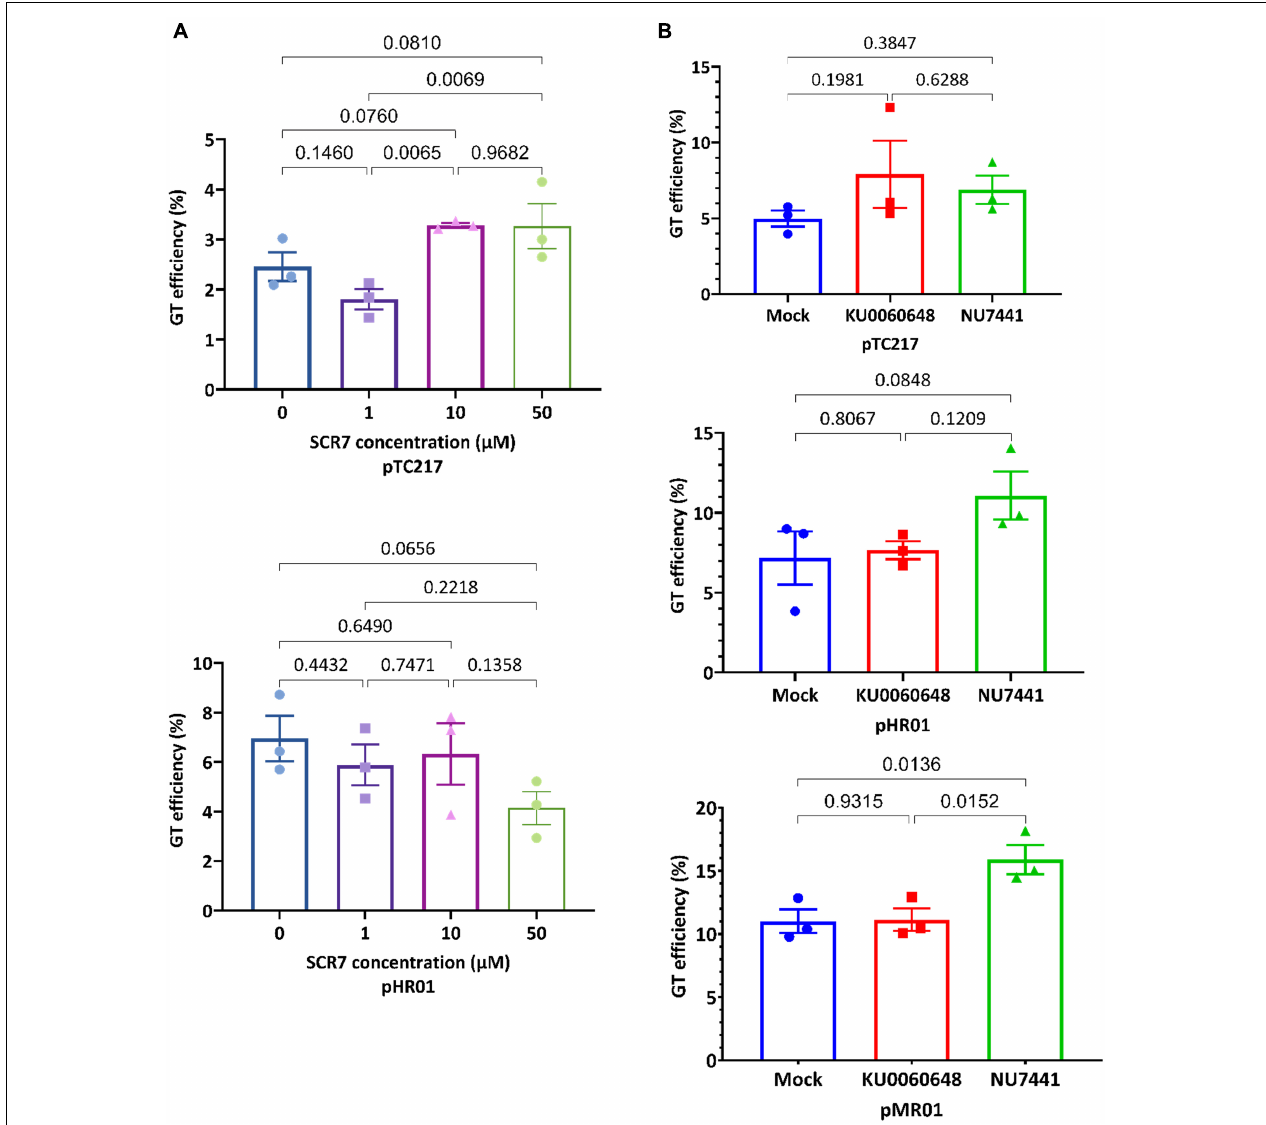
FIGURE 1 | Enhancement of GT efficiency by chemical treatments for blocking cNHEJ. (A) SpCas9 (pTC217, top panel) and LbCas12a (pHR01, bottom panel)-based GT efficiency obtained from the treatment of different SCR7 concentrations. SCR7 was added to the non-selection medium (NSEL), and the explants were incubated for 5 days before transferring to the selection medium (SEL5). The GT efficiencies were calculated at 21 dpt. (B) The impacts of KU0060648 and NU7441 on CRISPR/Cas-based GT. SpCas9-based pTC217 (top panel) and LbCas12a-based pHR01 (middle panel) were cloned with single geminiviral replicons, whereas LbCas12a-based pMR01 (bottom panel) was released from a multireplicon vector. The chemical was added to the non-selection medium (NSEL), and the explants were incubated for 5 days before transferring to the selection medium (SEL5). The GT efficiencies were calculated at 21 dpt. Multiple comparisons of the means and plotting were conducted by GraphPad Prism version 9 using one-way ANOVA and Fisher’s LSD test. The p -values of each compared mean pair are shown on the top of the